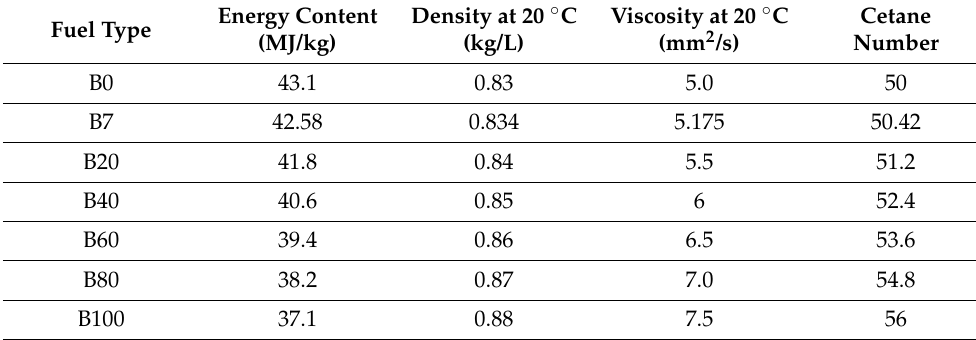
Table 1. Comparison of heating value of fuel